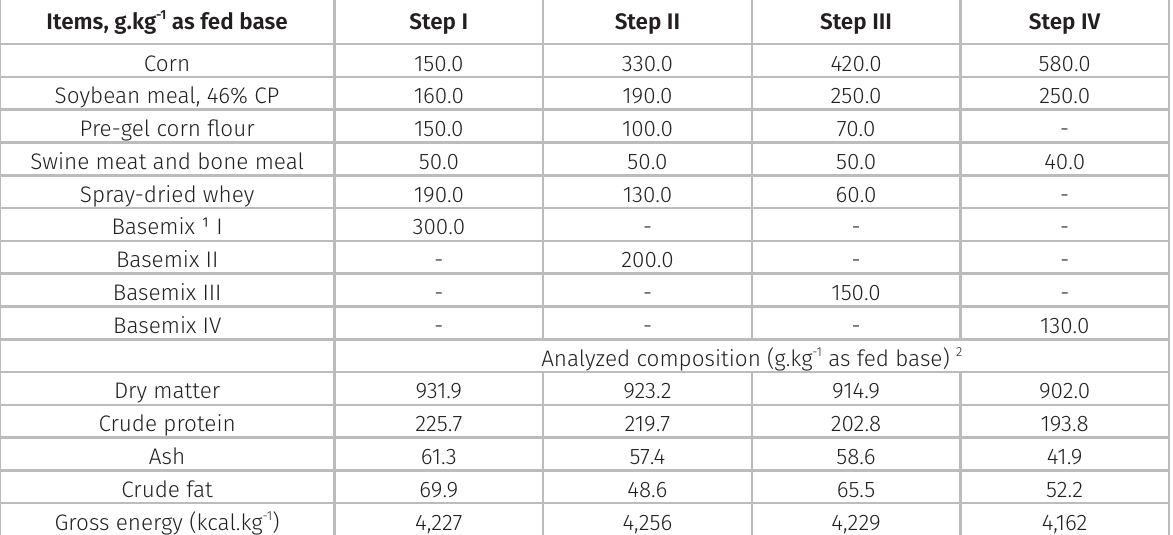
Table I. Ingredient and nutrient composition of experimental diets in nursery phase. Items, g.kg -1 as fed